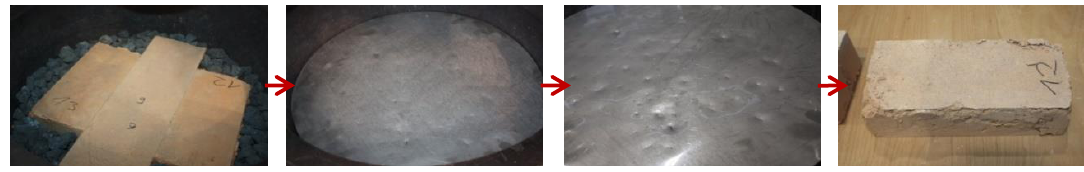
Figure 15. UCT of perlite brick insulation protected with steel liner.